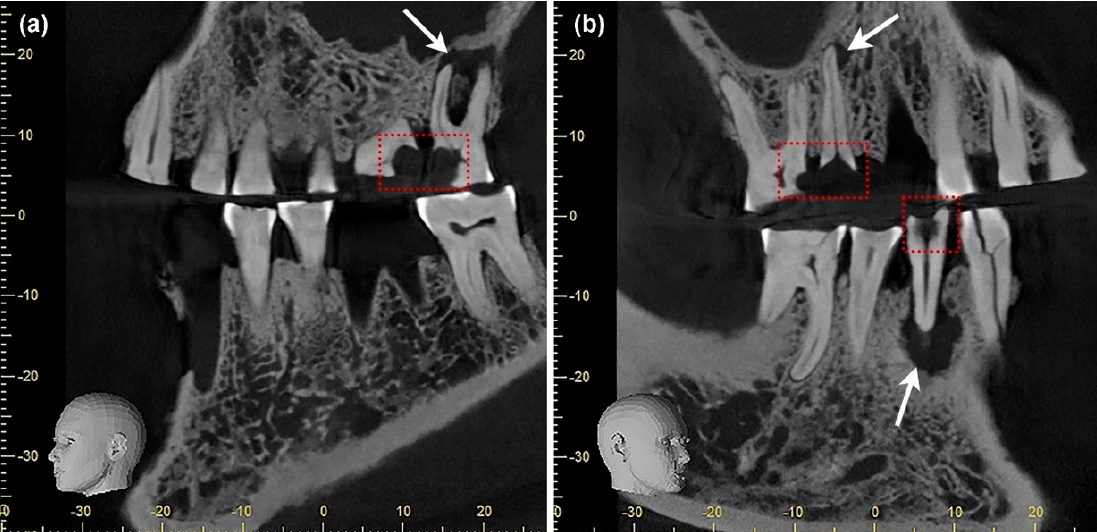
Figure 4. ( a , b ) The DVT images show that the dental cavities in some teeth (red rectangles) have led to periapical changes in the bone (white arrows): ( a ) in the left maxilla, the second molar (tooth 27) is affected; ( b ) in the right maxilla, there is a small lesion on the second premolar (tooth 15); and on the canine of the left mandible (tooth 33), there is a larger cavity that can be identified as a possible cyst due to its size. The latter has led to a vestibular abscess (cf. ( b ); DEB 484, 35–45 years, male).